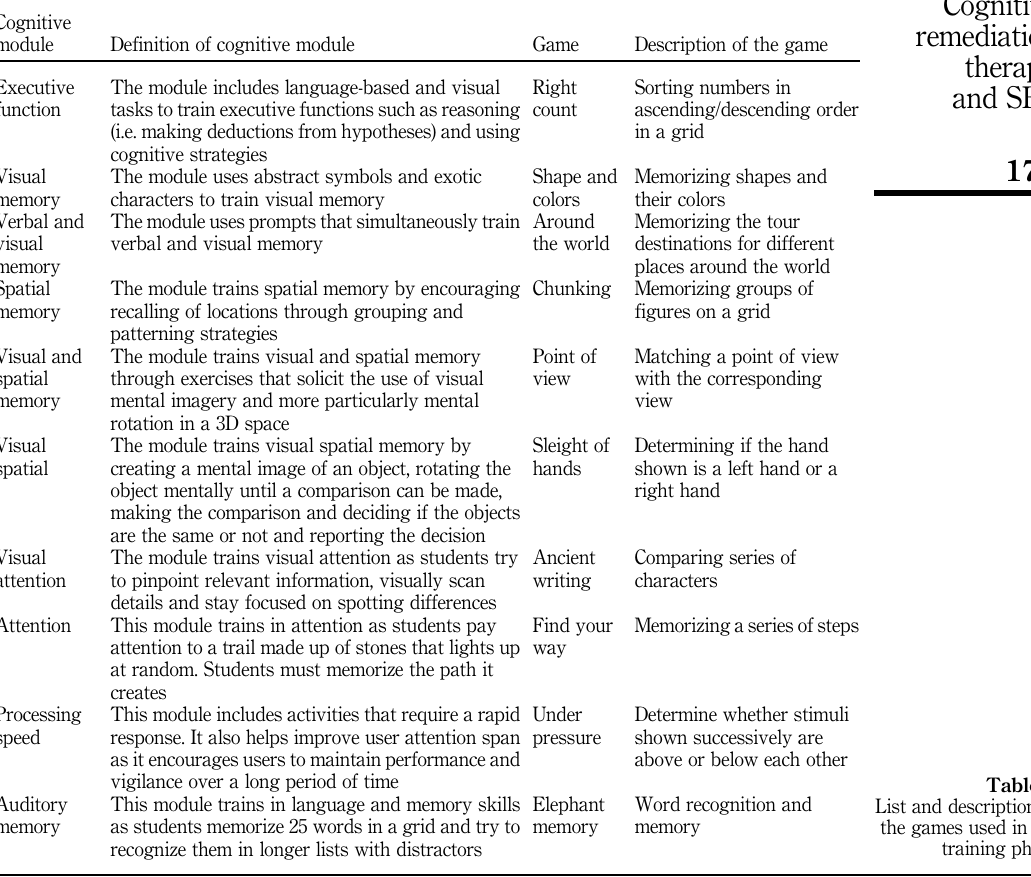
Table I. List and description